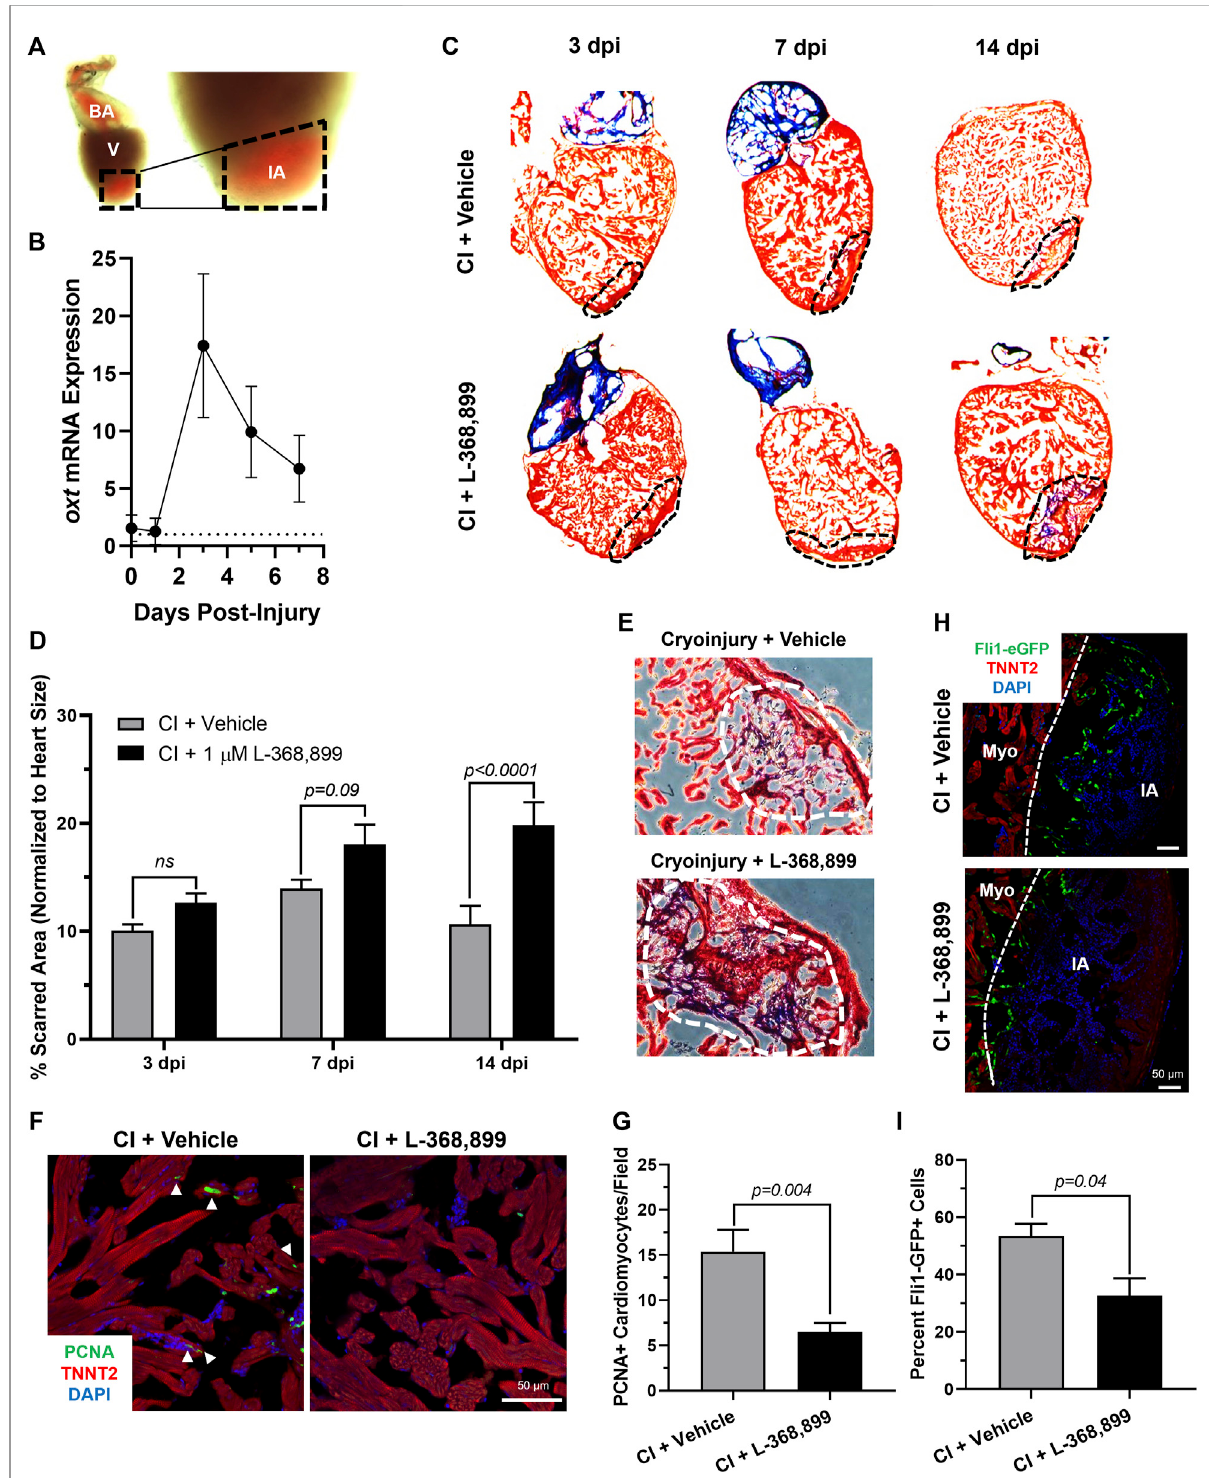
FIGURE 6 Oxytocin Signaling is Necessary for Proper Heart Regeneration in Zebra fi sh. (A) Example of a freshly cryoinjured zebra fi sh heart, dashed lines demarcate injured area. (B) Time course qRT-PCR data for oxt in zebra fi sh brains after cardiac cryoinjury; n = 3 per time point. (C,D) Masson ’ s trichrome staining (C) and quanti fi cation (D) of cryoinjured zebra fi sh hearts at 3, 7, and 14 dpi treated with and without 1 µM L-368,899. In (C) , myocardium is stained red, collagen is stained blue, dashed lines demarcate injured area, which is quanti fi ed in (D) ; n = 3 – 5 hearts per